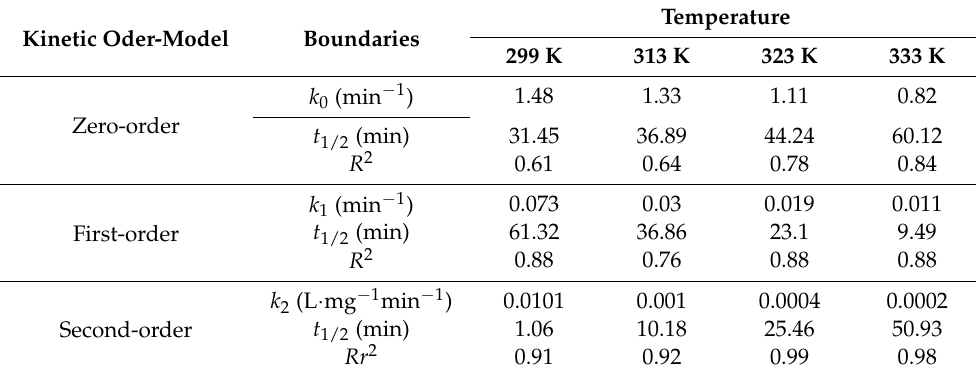
Table 4. Fitted kinetic reaction data for agricultural effluent oxidation reaction *. Temperature Kinetic Oder-Model Boundaries 299 K 313 K 323 K 333 K k 0 (min − 1 ) 1.48 Zero-order t 1/2 (min) 31.45 36.89 R 2 0.61 0.64 k 1 (min − 1 ) First-order k 2 (L · mg − 1 min − 1 ) 0.0101 0.001 Second-order Rr